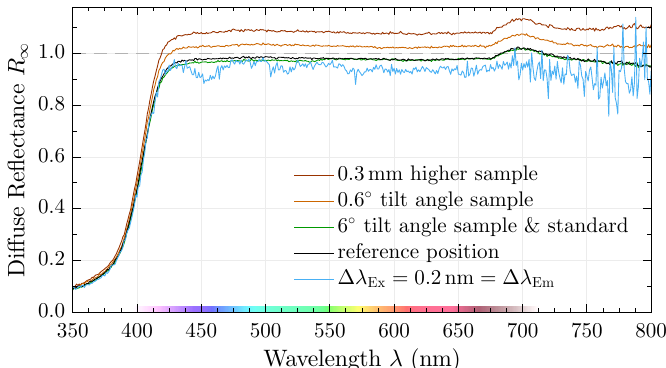
Figure 11. Comparison of the observed TiO 2 diffuse reflectance when the sample is displaced by 0.3mm upwards (brown) or tilted by 0.6 ◦ (orange) compared to the white standard’s position. For comparison, an equal tilt of both sample and white standard by 6 ◦ (green) and at reference positions (black) are shown. The effect of both monochromators operating at identical (narrow) bandwidths is displayed in